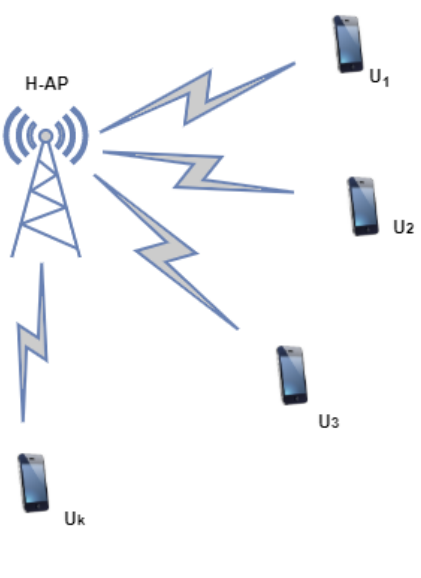
Figure 2. A wireless powered communication network (WPCN): A base station with a hybrid access point (H-AP) for energy and information transmission, and K single-antenna users.